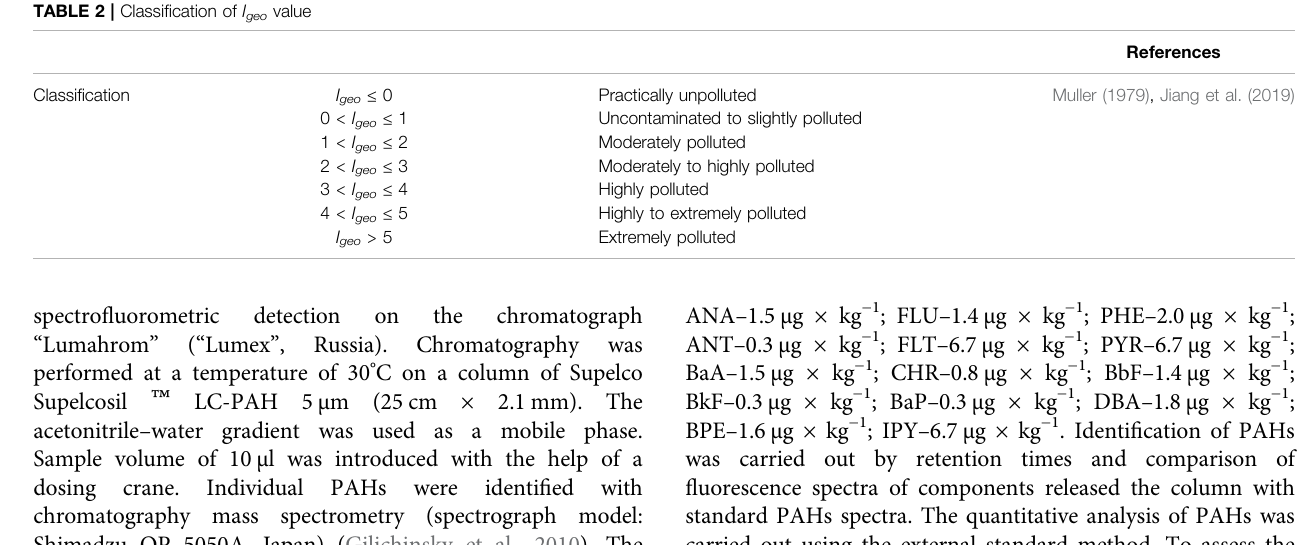
TABLE 2 | Classi fi cation of I geo